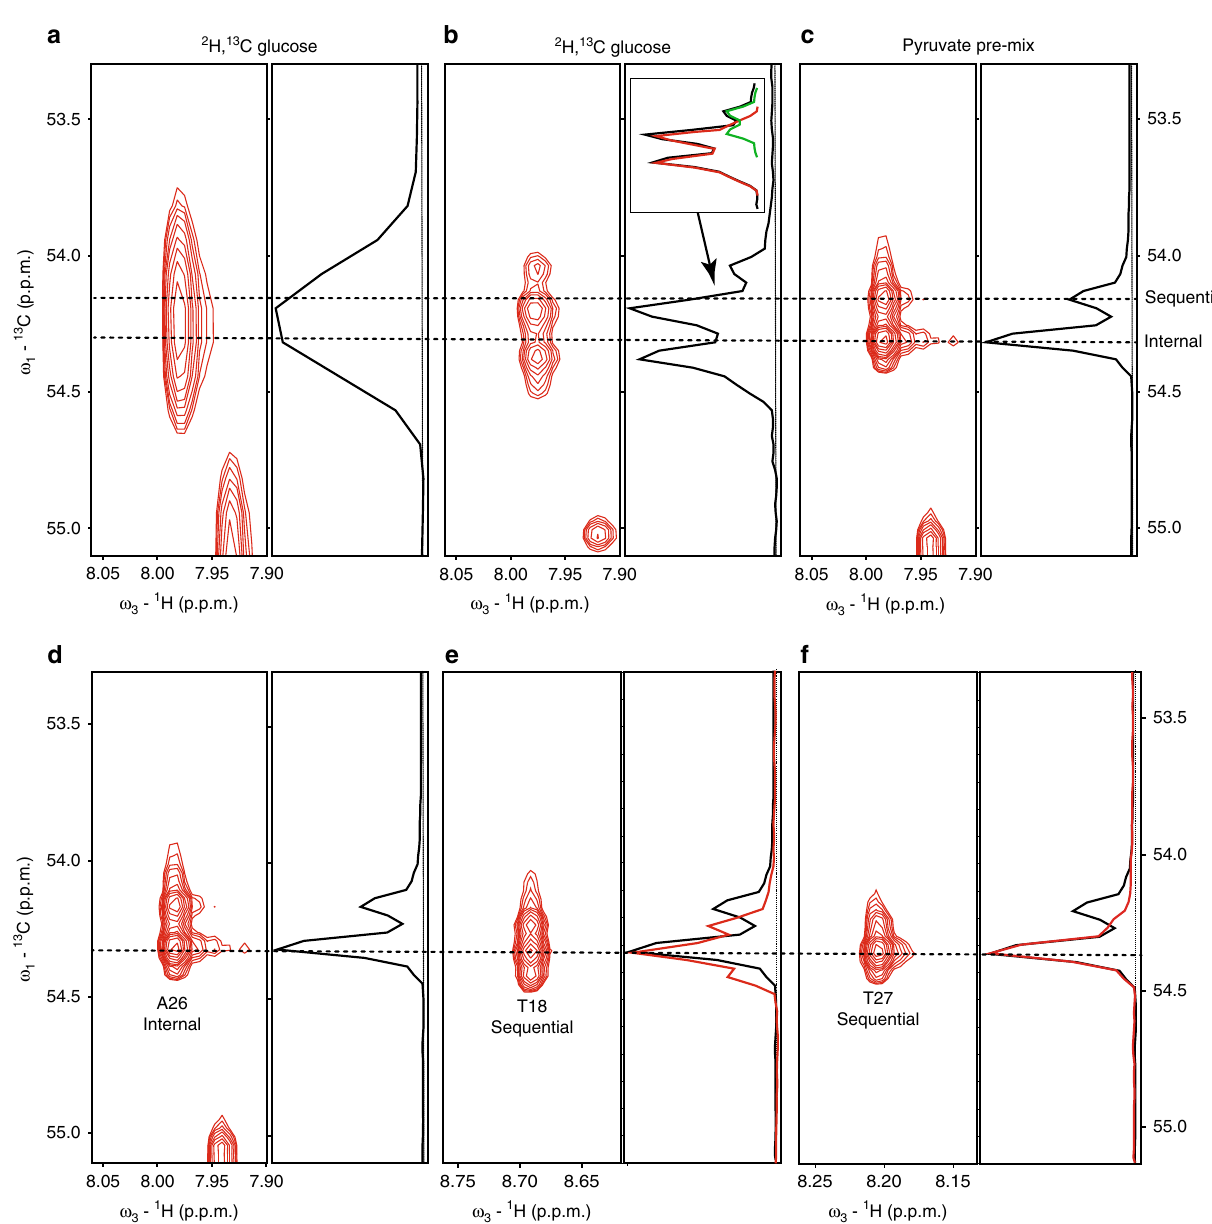
Fig. 3 Enhanced resolution and peak shape with pre-mix samples solves overlap problems in GB1. All panels show a 2D plot of a spin system from a 3D HNCA spectrum (red contours) along with a 1D trace (black line) along the 13 C α dimension. a A spin system from uniformly 13 C-labeled GB1 at standard HNCA resolution (~42 Hz). b Same protein sample as a with a higher resolution of ~5 Hz. The 1 J αβ coupling can be seen with overlap of the internal and sequential C α peaks in this system (see 1D plot inset). c Same protein system but the sample is prepared using the 2- 13 C and 3- 13 C pyruvate pre-mix labeling strategy. The internal and sequential C α peaks are now resolvable. d A repeat of c to clarify the comparison with e and f . The signal for the internal C α of A26 is labeled. e An incorrect sequential system, T18, that matches perfectly for chemical shift but not for the peak shape. The 1D trace of sequential T18 signal (red) is overlaid with the A26 1D trace (black). f The correct sequential assignment, T27. The 1D sequential trace of T27 (red) perfectly matches the 1D internal trace of A26. 1D traces in d – f are plotted to equalize intensity to help with visual pattern